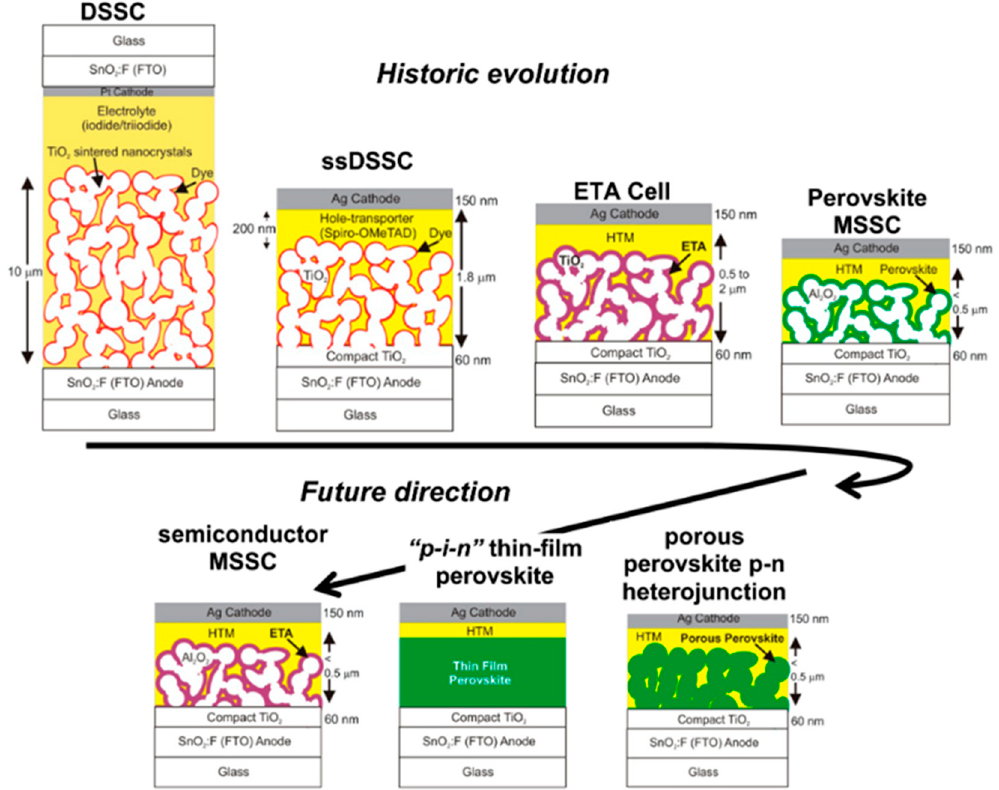
Figure 10. Historic evolution of the solar cell technology, starting from the electrolyte-based mesoscopic DSSC, the ssDSSC where the electrolyte is replaced with an organic p-type hole conductor, the ETA cell where the dye is replaced with an ETA semiconductor layer, to the MSSC, where the ETA is replaced with a perovskite absorber and the n-type TiO 2 is replaced with a porous insulating scaffold. Three likely future directions for the perovskite technology are indicated: (i) porous perovskite distributed p-n heterojunction solar cells, where the Al 2 O 3 is removed but the perovskite is directly structured to give a porous film subsequently filled in with a charge conductor; (ii) thin-film p–i–n perovskite solar cells where no porosity is required and the device takes on the structure of an intrinsic, or at least ambipolar, thin perovskite film sandwiched between p- and n-type charge-extracting contacts; or (iii) semiconductor MSSCs, where any solution-processed semiconductor, such as SbS, can be structured by the porous scaffold to deliver a MSSC